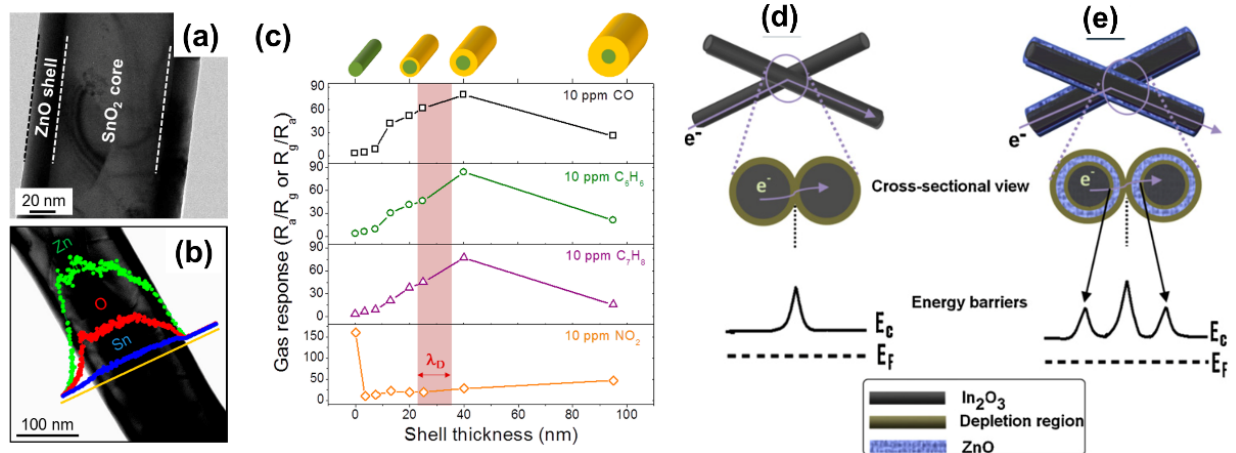
Figure 20. ( a ) Nanowire with SnO 2 core and ZnO shell structure; ( b ) EDS of core–shell nanowire; ( c ) shell thickness-dependent sensing performance towards CO, benzene, toluene, and NO 2 . Reprinted from reference [327] with permission from the American Chemical Society. ( d , e ) Schematics of the hydrogen-sensing mechanism for In 2 O 3 nanowires and In 2 O 3 /ZnO C–S nanowires sensors. Reprinted from reference [334] Copyright 2011 Elsevier.